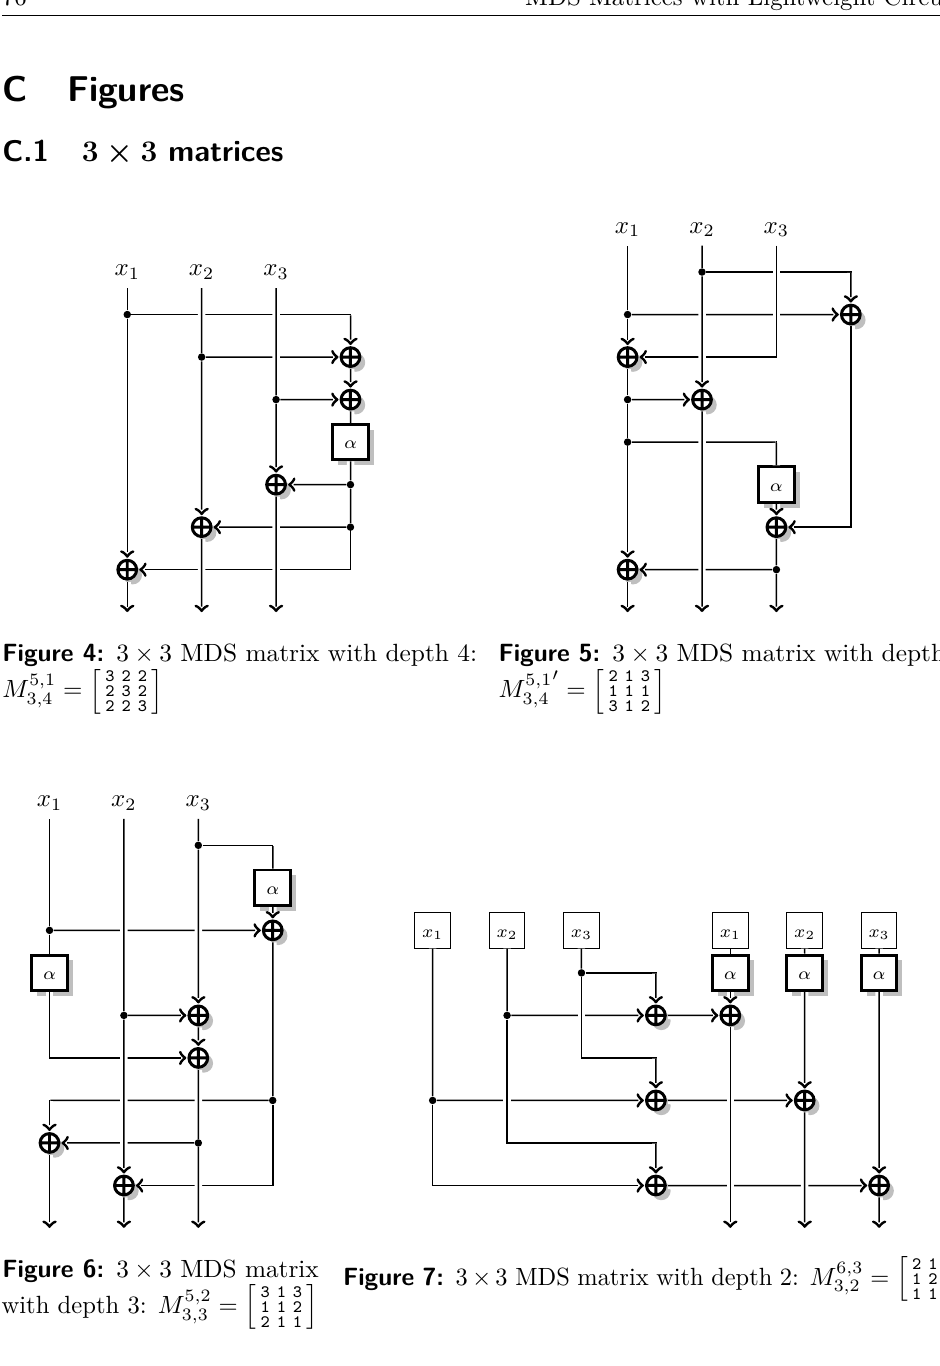
Figure 7: 3 × 3 MDS matrix with depth 2: M 6 , 3 h 3 1 3 i = 1 1 2 3 , 3 2 1 1